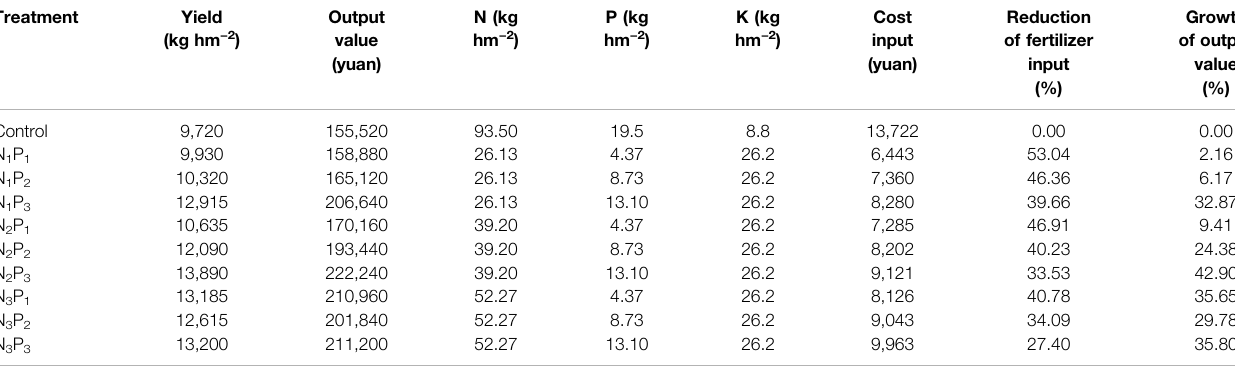
TABLE 5 | Economic pro fi ts of L. barbarum under different fertigation treatments.